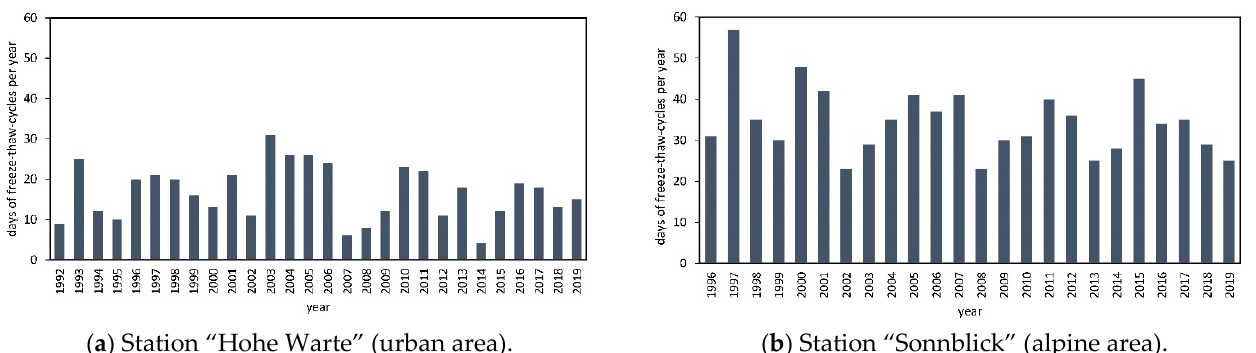
Figure 3. Overview of the number of days of freeze-thaw cycles per year in accordance to the values taken from [24].